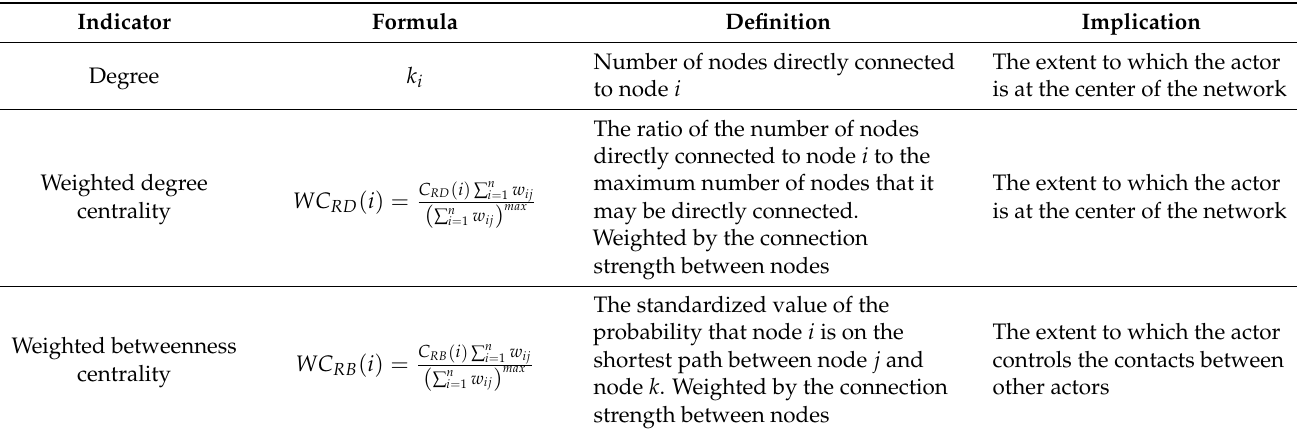
Table 2. Main analysis indicators of network